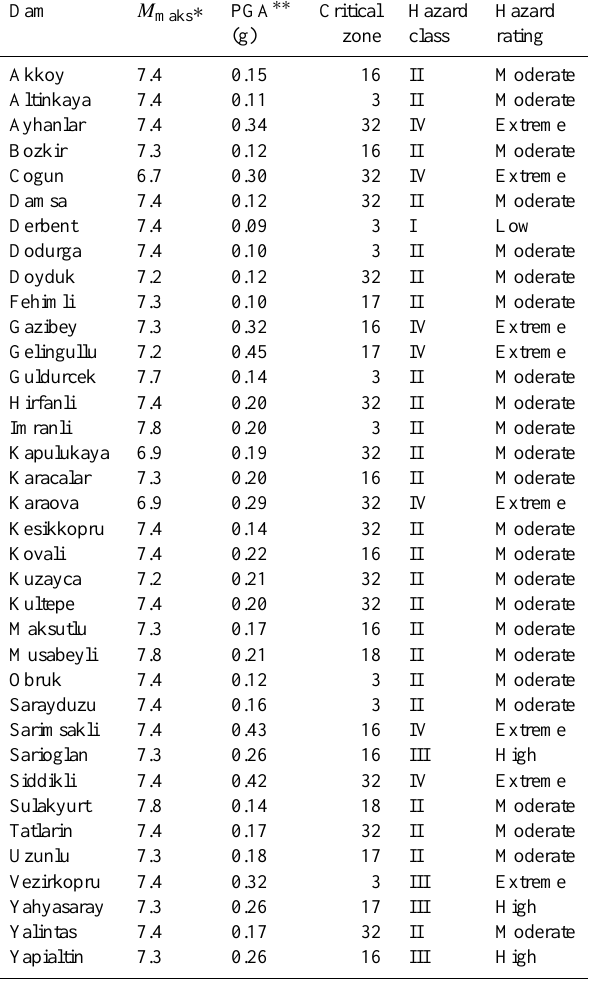
Table 2. Summary of seismic hazard analyses performed for the large dams within the Kizilirmak Basin.